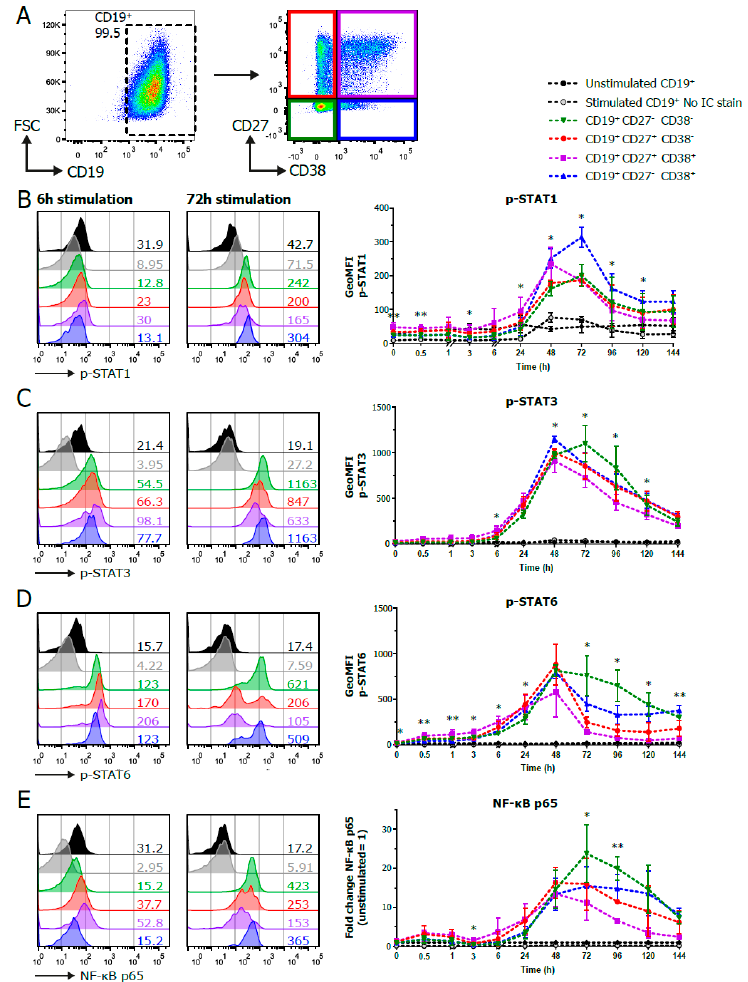
Figure 2. Phosphoflow analysis of stimulated human B cells show differences between CD27/CD38 subpopulations. Human B cells ( n = 3–4) were stimulated with a human-CD40L-expressing 3T3 feeder layer, an anti-Ig F(ab) 2 mix (5 ug/mL) targeting IgM/IgG/IgA and recombinant IL-4 (25 ng/mL) and IL-21 (50 ng/mL) cytokines, and multiple signaling proteins were analyzed by phosphoflow analysis over the course of a 6-day culture. ( A ) Representative FACS plots show the gating strategy for CD19 + and CD27/CD38 subpopulations by phosphoflow analysis after 96 h stimulation. ( B–E ) Representative histogram overlays of p-STAT1 ( B ), p-STAT3 ( C ), p-STAT6 ( D ) and NF- κ B p65 ( E ) staining in unstimulated and stimulated CD19 + and CD27/CD38 subpopulations after 6 and 72 h stimulation (left), and the quantification of the geometric MFI (GeoMFI) within the different subpopulations over the course of 6 days of culture (right). Values depicted next to histograms represent the corresponding GeoMFI. For NF- κ B p65 (E), fold change was calculated by normalizing to the expression in unstimulated CD19 + cells (set at value of 1). n = 3–4; p values were calculated using a mixed-e ff ect analysis with Tukey’s multiple-comparison test; * p < 0.05 and ** p < 0.01. Significance * is depicted if there was a significant di ff erence between the green, red, purple or blue CD27 / CD38